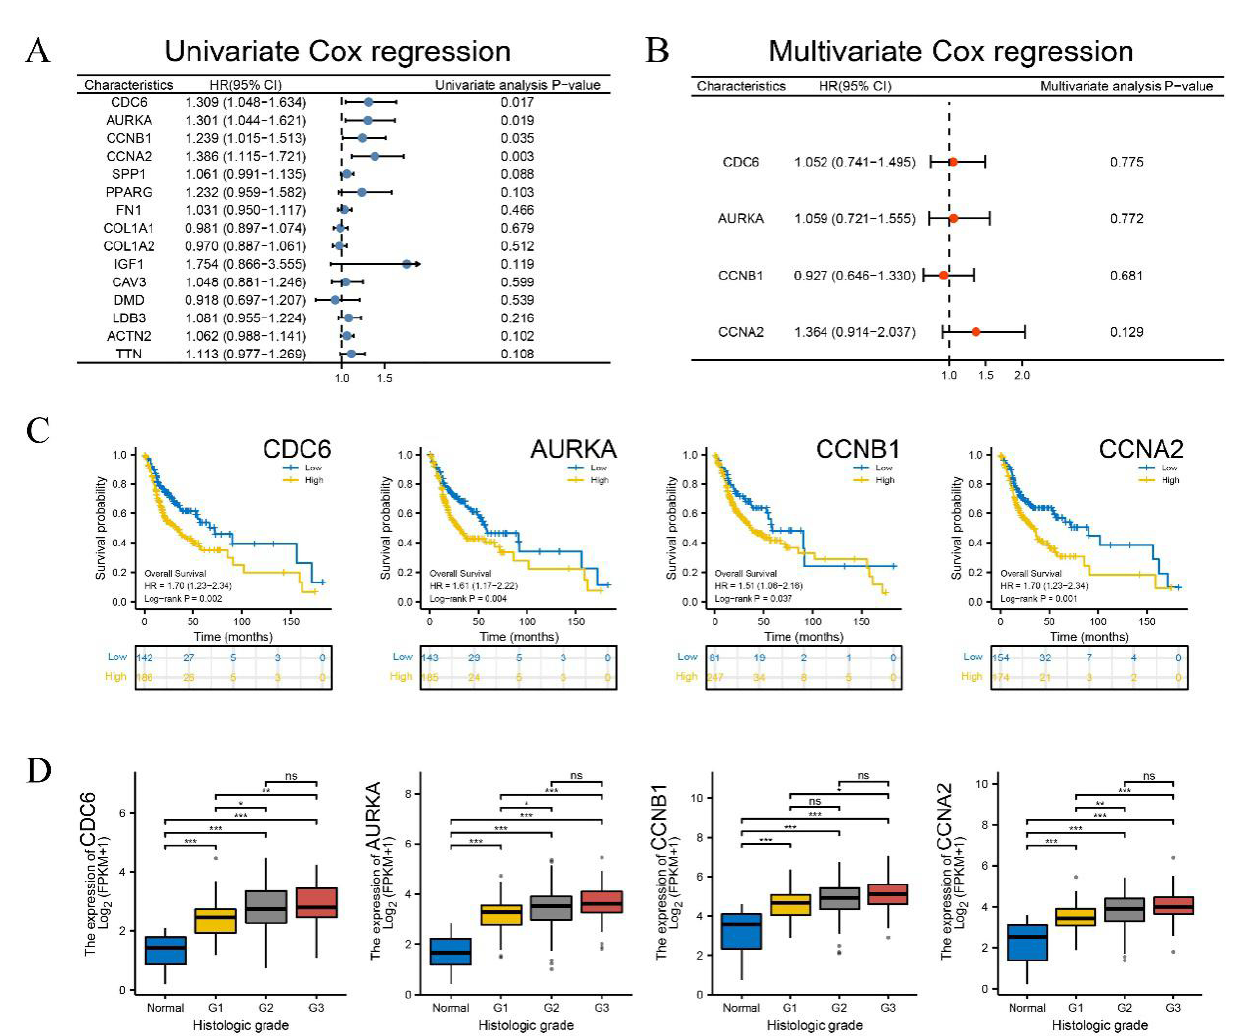
Fig. 6. Screening the hub genes associated with the prognosis of OSCC patients. (A) Univariate cox regression showed the relationship between 15 hub genes and patient prognosis. P < 0.05. (B) Stepwise multivari- ate cox regression excluded genes that were not significantly associated with the patient's prognosis. (C) Kaplan–Meier plot and the log-rank test showed the survival rate of patients with high or low expression of these genes. P < 0.05. (D) Box plots showed the expression of these four genes in different OSCC pathological grades. G1: highly differentiated, G2: moderately differentiated, G3: poorly differentiated. *** P < 0.001, ** P < 0.01, * P <